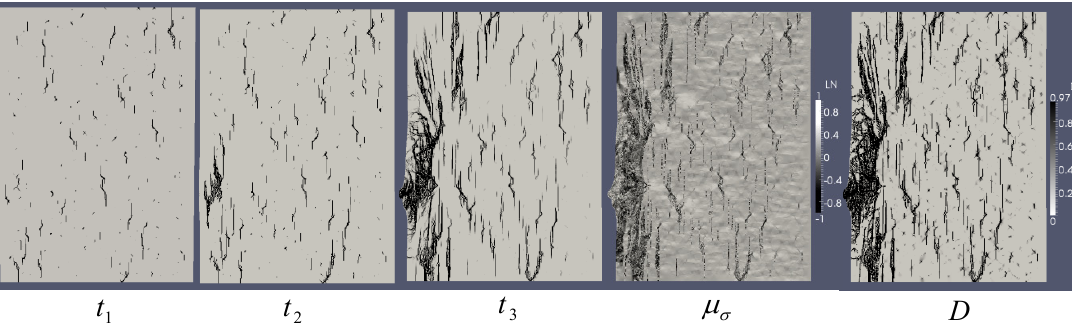
 ), damage function ( D ) in the 